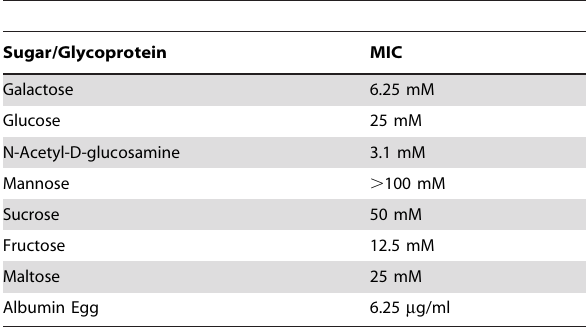
Table 1. Comparison of the carbohydrate-binding specificities of